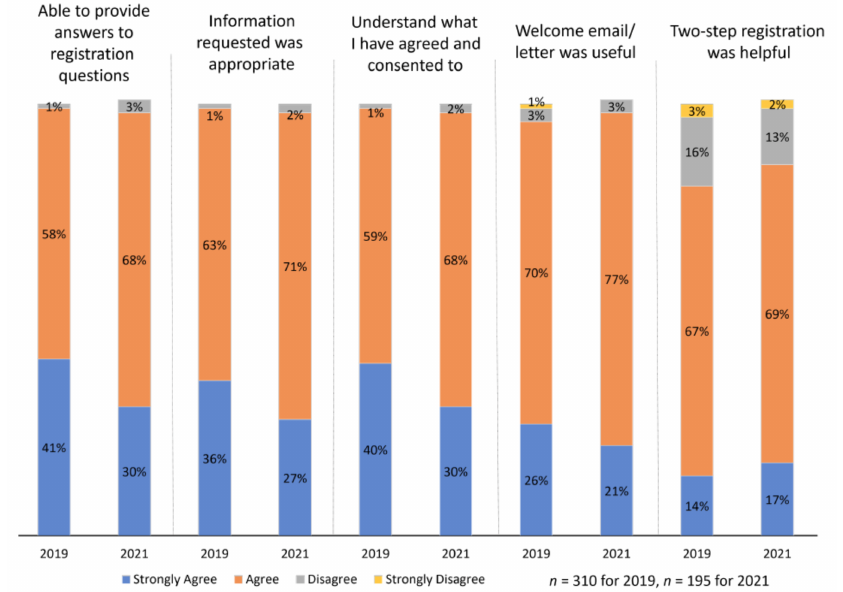
Figure 4. Experience with registration processes 2. Note: 2021 survey respondents ( n = 195) were newly registered since 2019